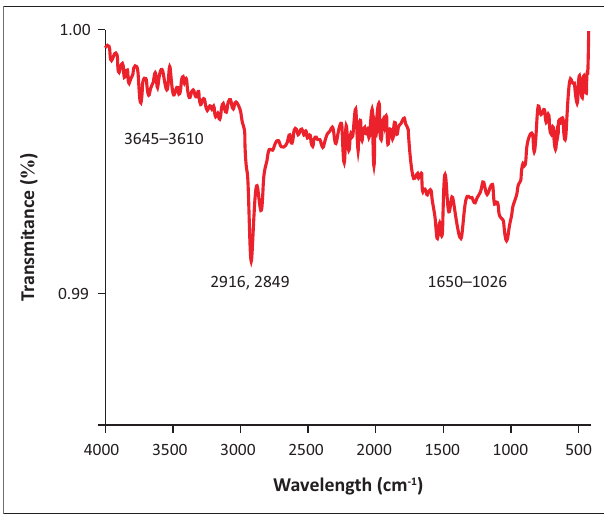
FIGURE 6: Fourier transform infrared spectra of Cannabis sativa methanol extract from the leaves after silver nanoparticles TABLE 1: Minimum inhibitory concentration of biosynthesised silver nanoparticles. Microorganism